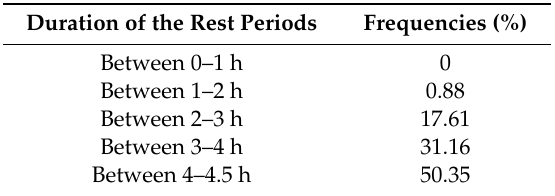
Table 2. Frequencies of the rest periods between the morning and afternoon exercise bouts, and between the afternoon and evening exercise